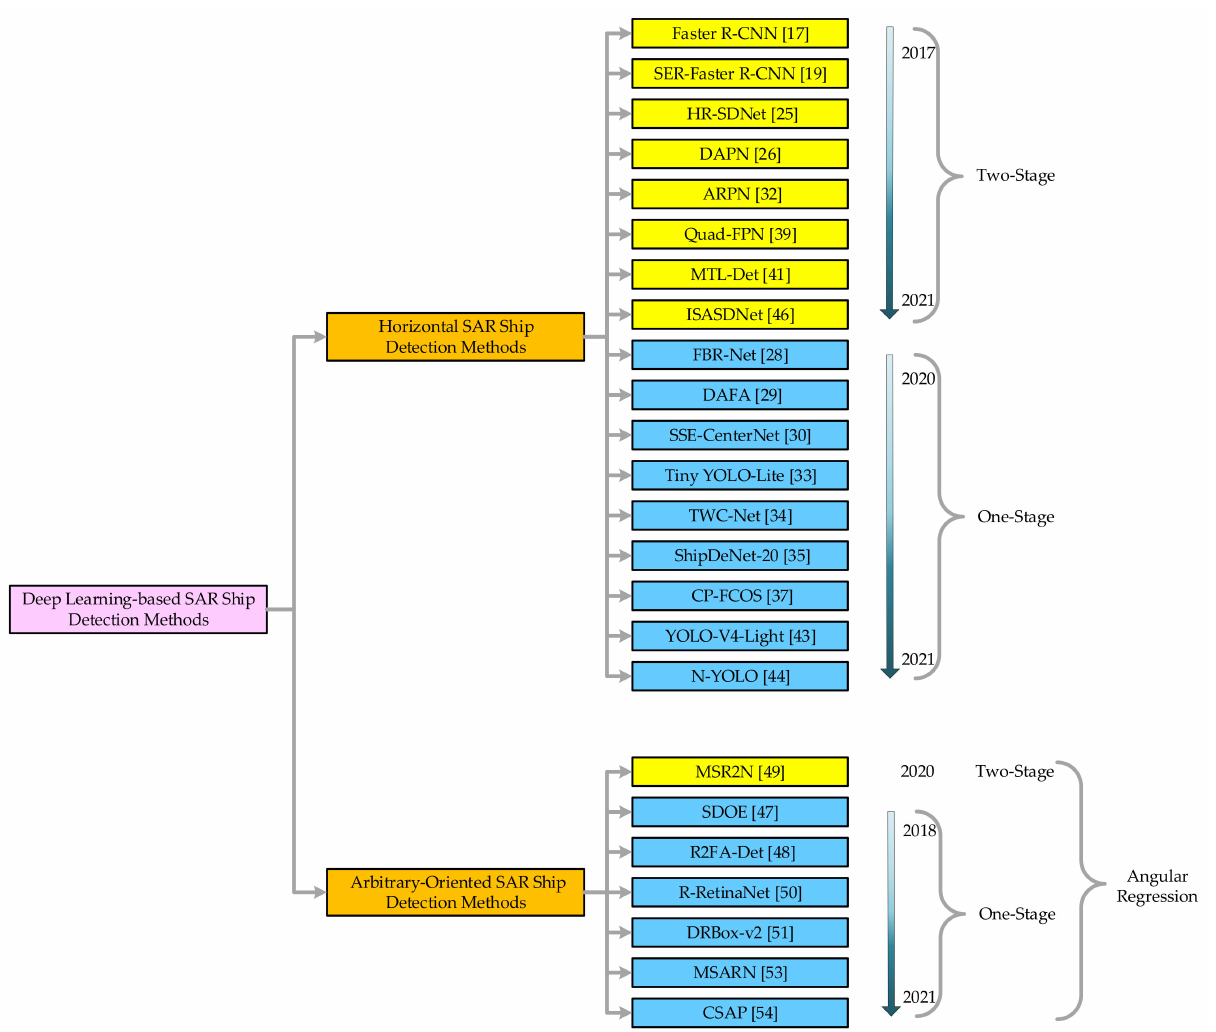
Figure 1. Deep learning-based SAR ship detection methods.